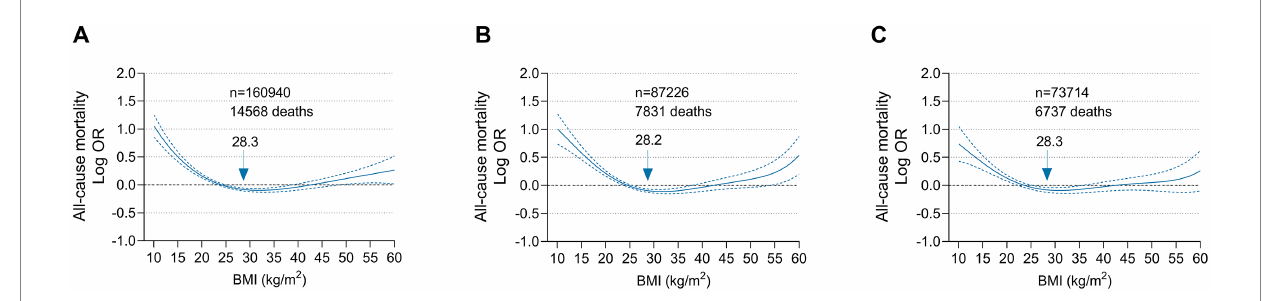
FIGURE 3 Multivariable adjusted odds ratios for all-cause mortality according to BMI on a continuous scale among (A) Overall population, (B) Men and (C) Women. Odds ratios (solid line) and 95% confidence intervals (dashed lines) were from cubic spline curves based on the generalized additive model. Arrows indicate BMI associated with the lowest mortality.